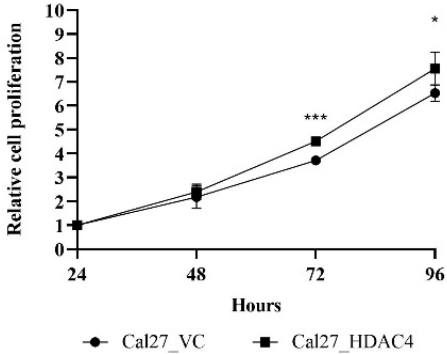
Figure 2. Effects of HDAC4 overexpression on cell proliferation analyzed over a time period up to 96 h by MTT assay. The value for 24 h was defined as a starting point with a relative proliferation set as 1. Values represent means ± SD of at least three independent experiments. Significance was calculated by t -test (* p ≤ 0.05, *** p ≤ 0.001).